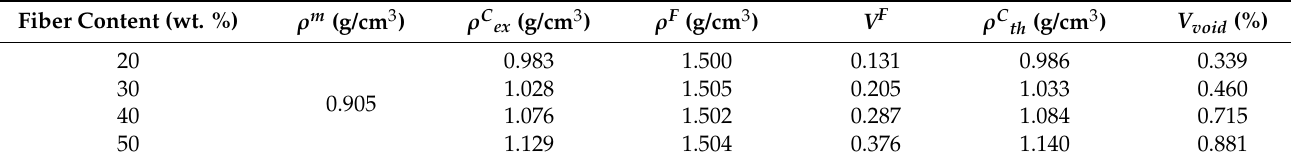
Table 1. Fiber content, matrix density ( ρ m ), experimental composite density ( ρ C ex ), fiber density ( ρ F ), fiber volume fraction ( V F ), theoretical composite density ( ρ C th ), and void volume percentage ( V void ). Fiber Content (wt.